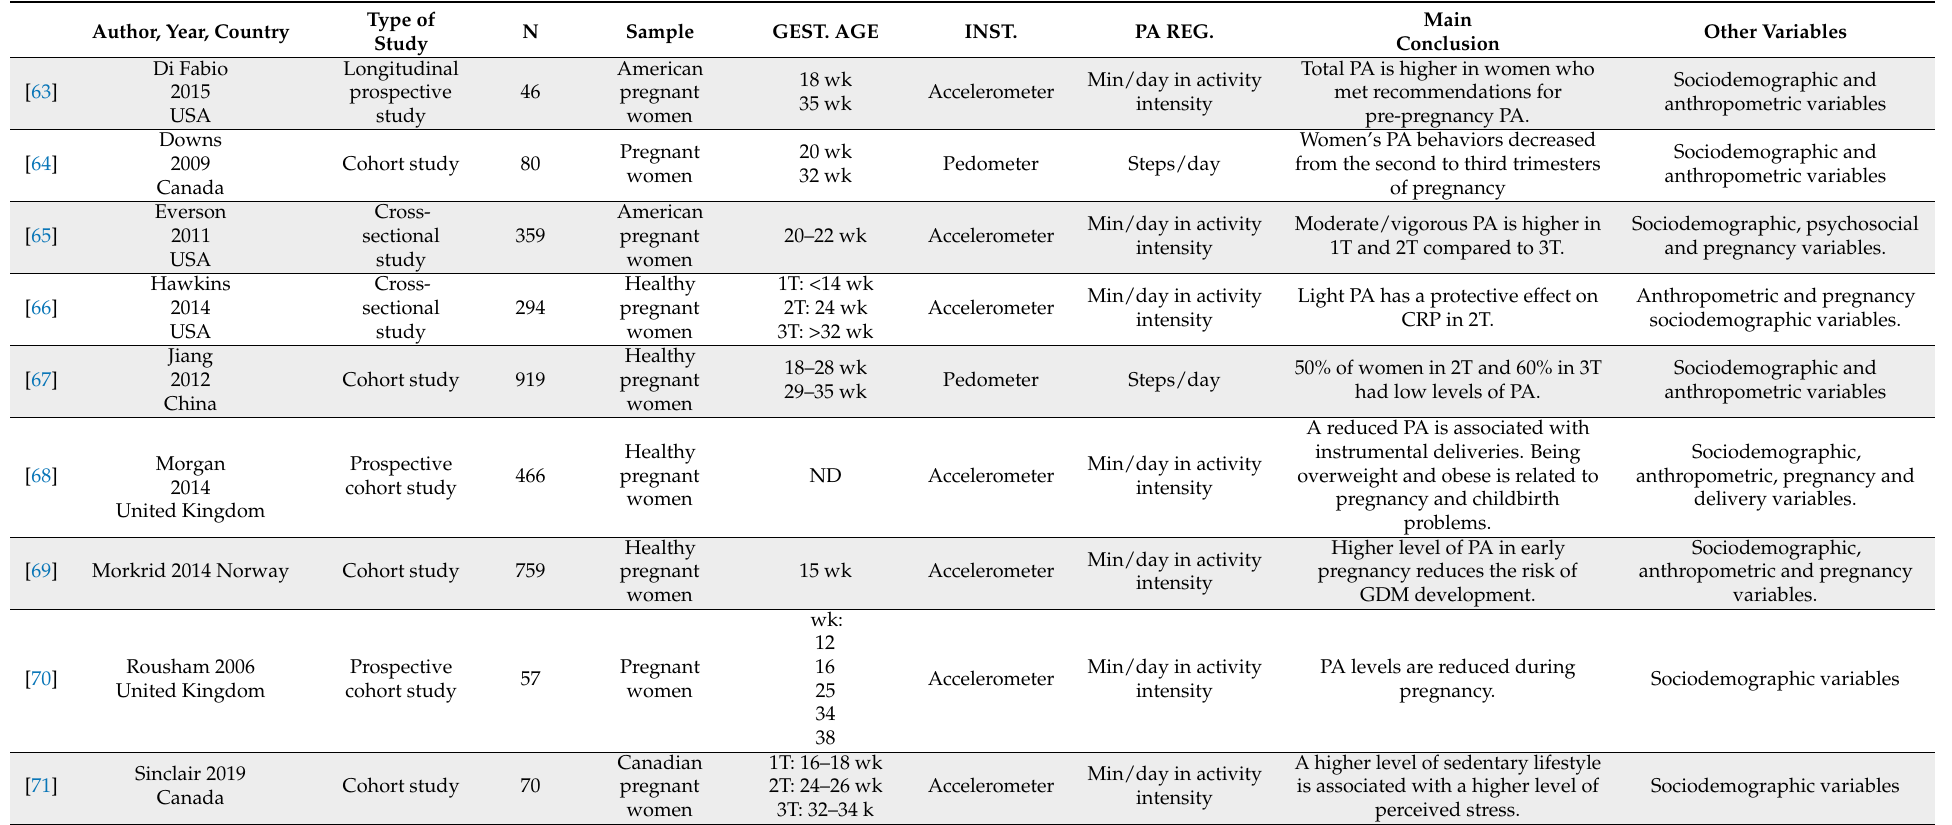
Table 6. Direct measurements of physical activity during